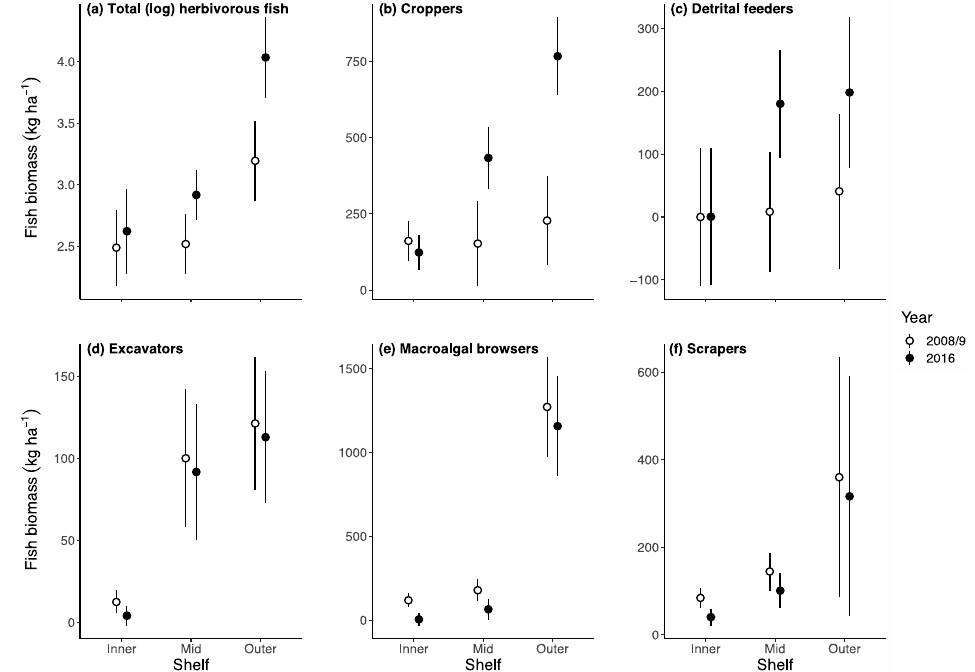
Figure 4. Cross-shelf differences (fitted values 95% confidence intervals) in biomass (kg/ha) of ( a ) the total herbivorous fish assemblage (log transformed), ( b ) algal croppers, ( c ) detrital feeders, ( d ) excavators (less Bolbometopon), ( e ) macroalgal browsers, and ( f ) scrapers, in 2008/9 (white) and 2016 (black).